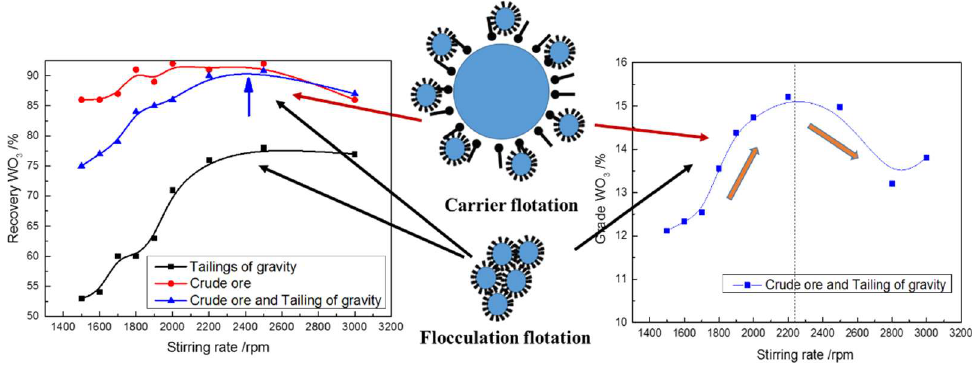
Figure 7. Flocculation and carrier flotation of fine particles.